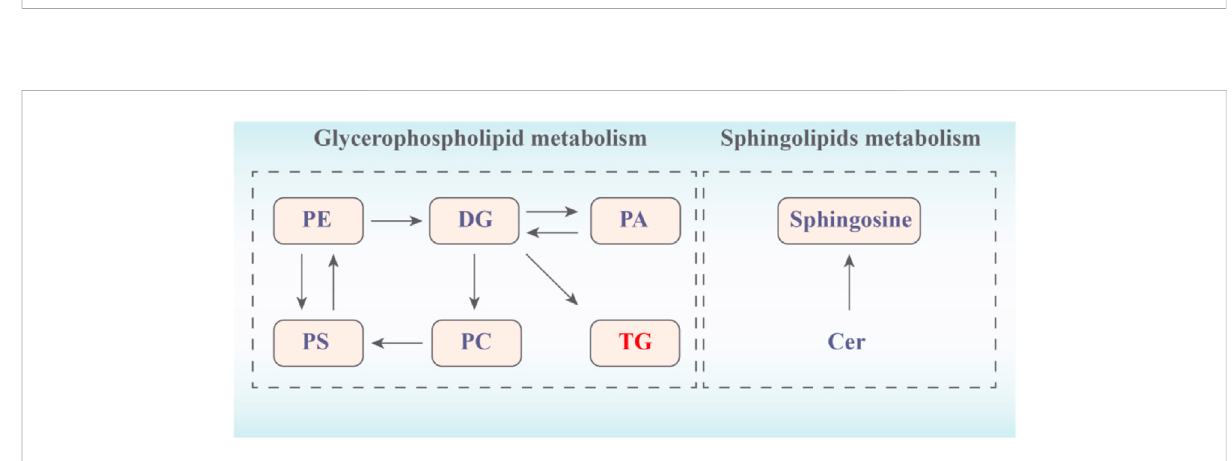
FIGURE 7 Network of changes in potential biomarkers of SHR regulated by hawthorn (red: upregulated, blue: downregulated).